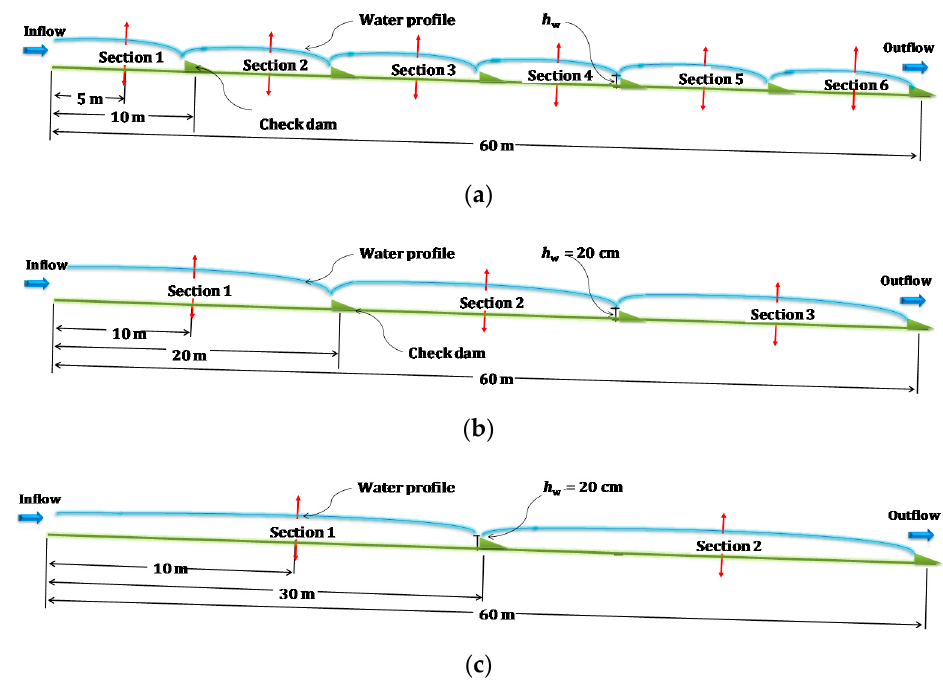
Figure 9. Side view of the channel for di ff erent check dam design cases: ( a ) case 1, case 2, and case 3; ( b ) case 4; ( c ) case 5.